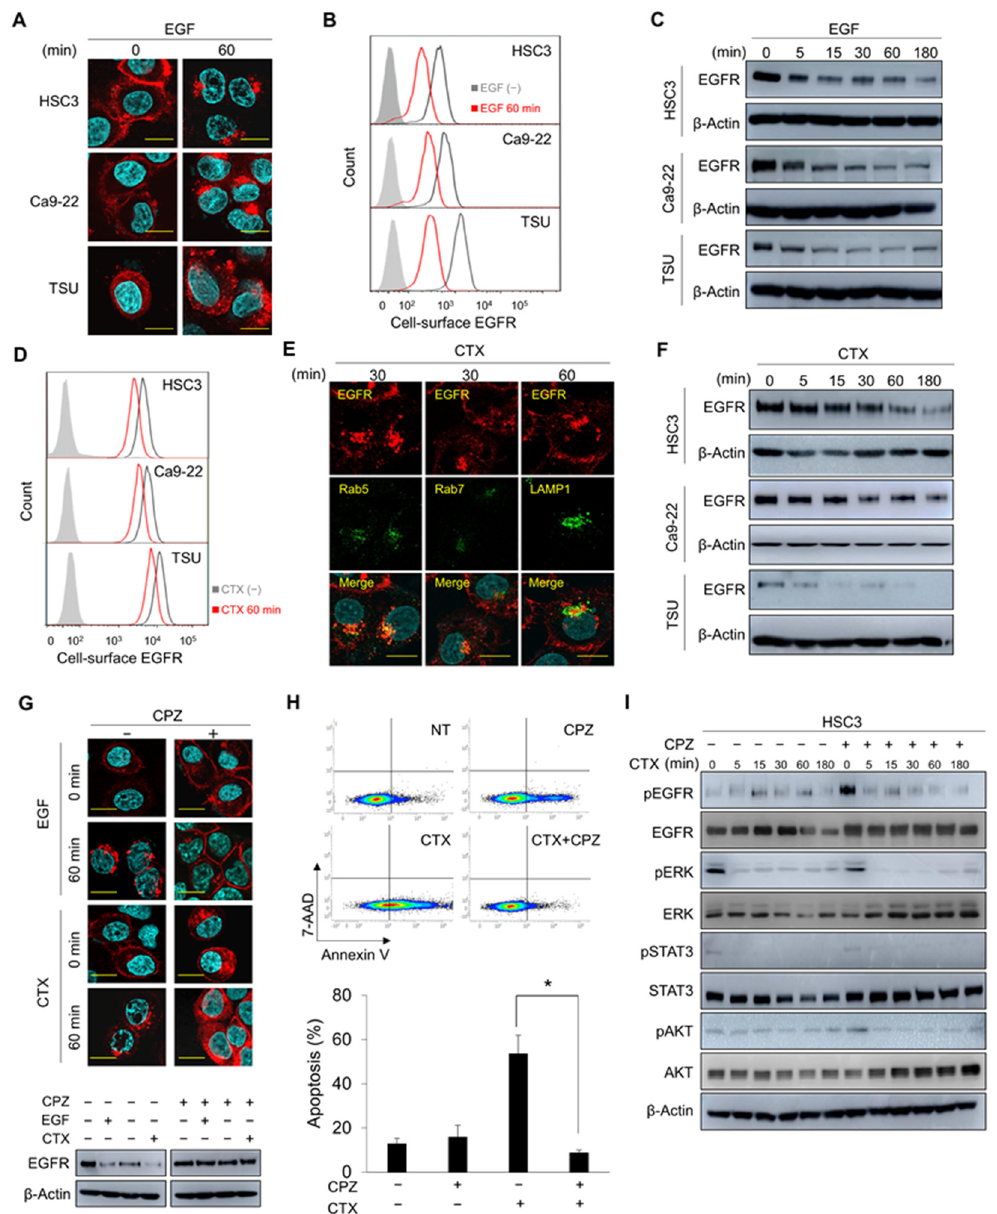
Figure 1. CME of EGFR is essential for CTX-induced apoptosis. ( A , B ) Localization of EGFR after EGF stimulation. HSC3, Ca9-22, and TSU cells were stimulated with 100 ng/mL EGF for 60 min. ( A ) EGFR localization was analysed via immunofluorescence staining. Scale bars, 10 µm. ( B ) Cell-sur- face EGFR was analysed using flow cytometry. ( C ) Amount of total EGFR after EGF stimulation. Cells were stimulated with 100 ng/mL EGF for the indicated times and total EGFR expression was analysed by using Western blotting. ( D ) Cell-surface EGFR expression after CTX treatment. Cells were treated with 100 µg/mL CTX for 60 min, and then cell-surface EGFR was stained with an anti- EGFR antibody (clone LA1). ( E ) Co-localization of EGFR with endosomes and lysosomes after CTX treatment. The localizations of EGFR and the endosome and lysosome markers were analysed via immunofluorescence staining after 100 µg/mL CTX treatment for 30 min (Rab5 and Rab7) or 60 min (LAMP1). Scale bars, 10 µm. ( F ) Amount of total EGFR expression after EGF stimulation. Cells were stimulated with 100 µg/mL CTX for the indicated times and total EGFR expression was analysed by using Western blotting. ( G ) Effects of CPZ on EGFR internalization and degradation after EGF or CTX treatment. HSC3 cells were pretreated with 5 µM CPZ for 30 min and were then stimulated with 100 ng/mL of EGF or 100 µg/mL of CTX for 60 min. CHX was added before adding CPZ. The localization of EGFR was analysed via immunofluorescence staining (upper panels). Total EGFR